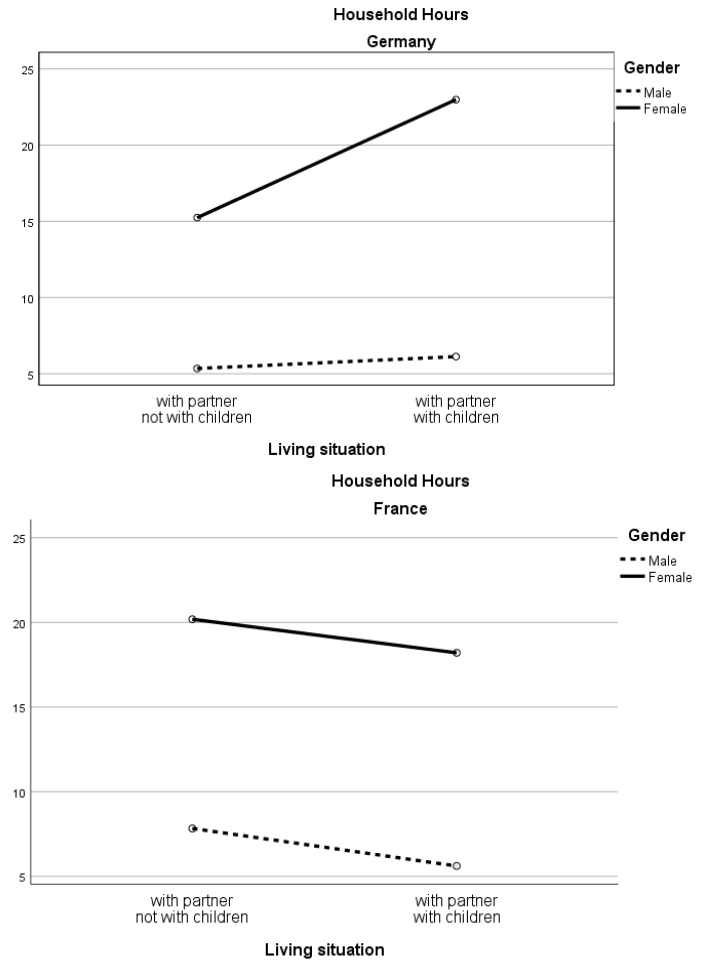
Figure 2. Three-way interaction between gender, country and home for household hours.